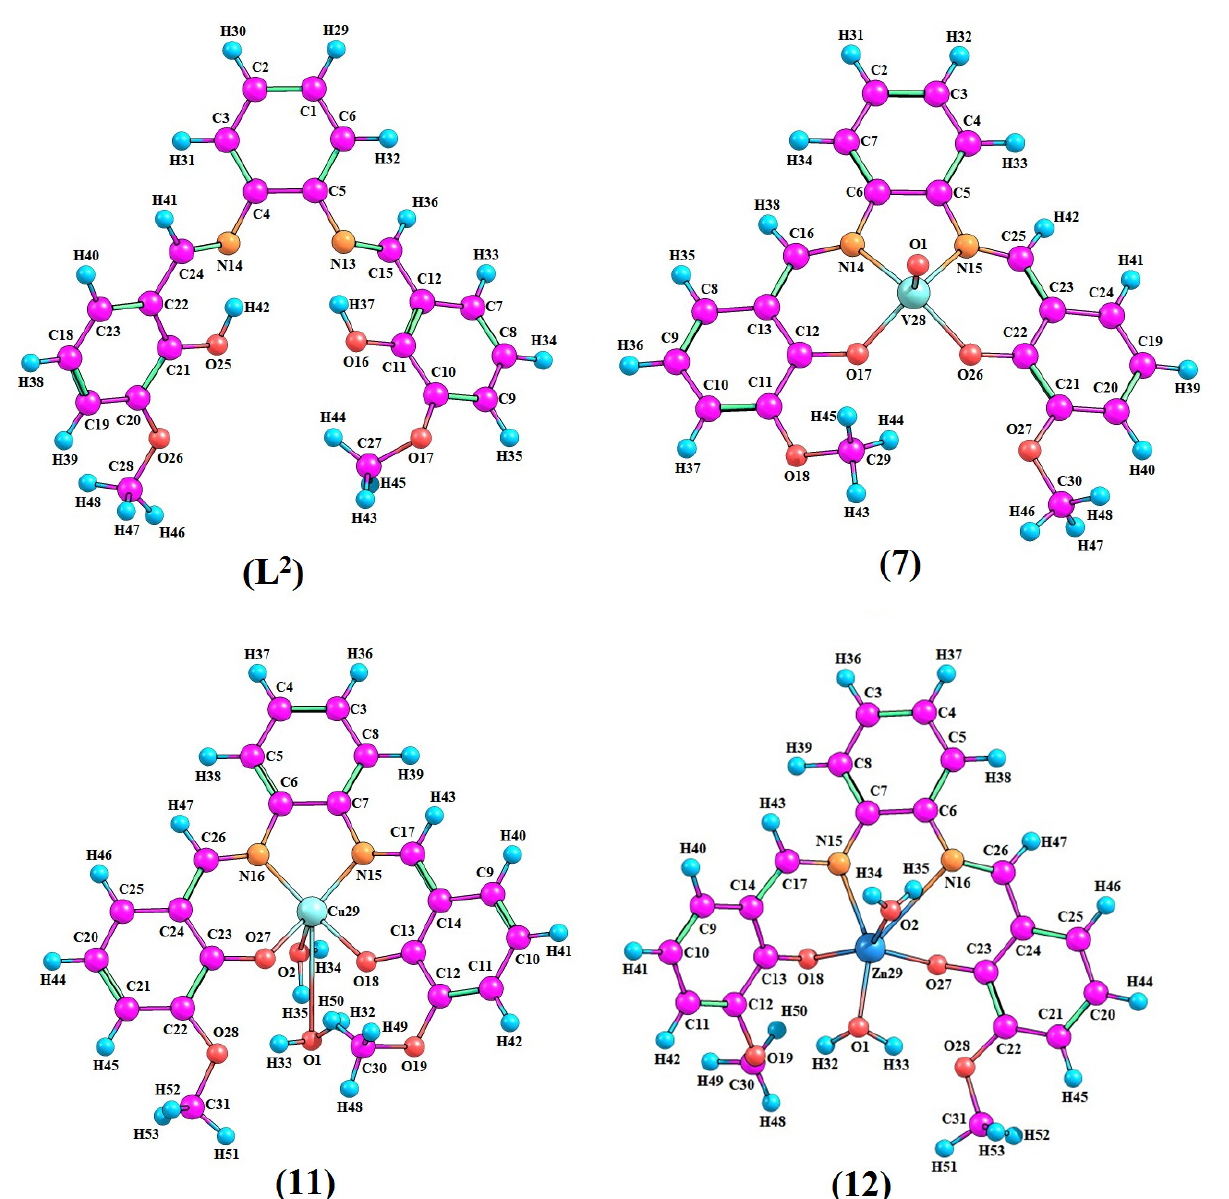
Figure 2. View of optimized geometrical structures of o -phenylenediamine ligand (L 2 ) and its derived metal complexes (7) , (11) and